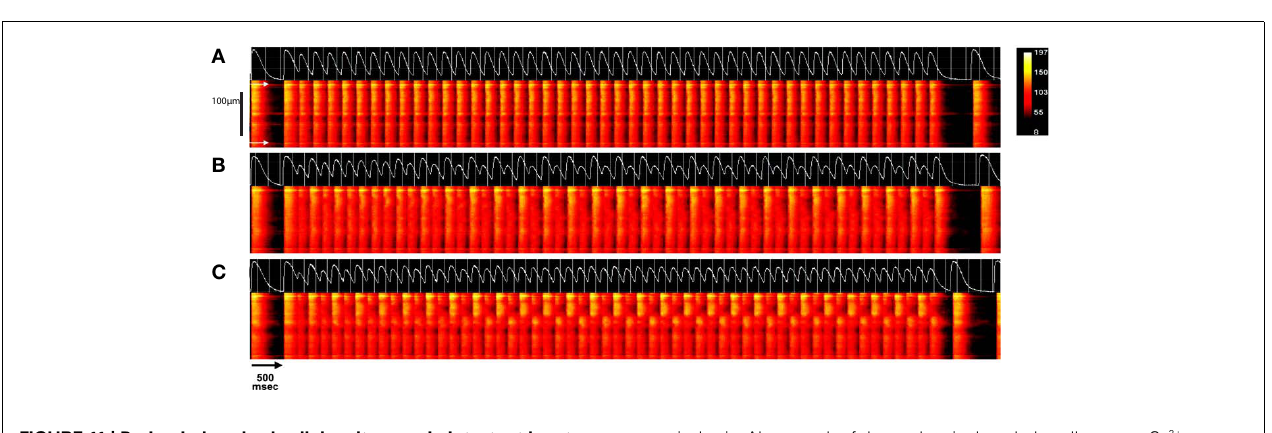
FIGURE 11 | Pacing-induced subcellular alternans in intact rat heart. The intracellular Ca 2 + concentration of individual myocytes were recorded in situ within an intact rat heart using confocal line-scan imaging. a transients recorded along the long axis of a single myocyte (with cell boundaries indicated by white arrows in (A) ), are shown. Following a train of stimuli at a cycle length of 500ms, the cycle length was decreased to 220ms (A) , 190ms (B) , or 180ms (C) for approximately 50 stimuli, after which pacing was resumed at the original rate. In each panel, the line-scan results of the last stimulus at the basal rate, the test train at the faster cycle length, and the first beat after return to slower pacing are shown with time on the horizontal axis and position on the